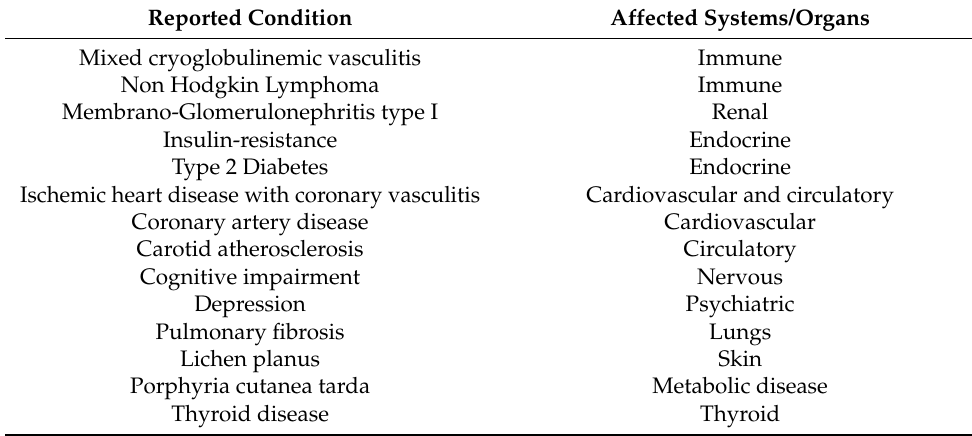
Table 1. Most frequent and well-characterized HCV-infection-associated extrahepatic manifestations. Reported Condition Affected Systems/Organs Mixed cryoglobulinemic vasculitis Immune Non Hodgkin Lymphoma